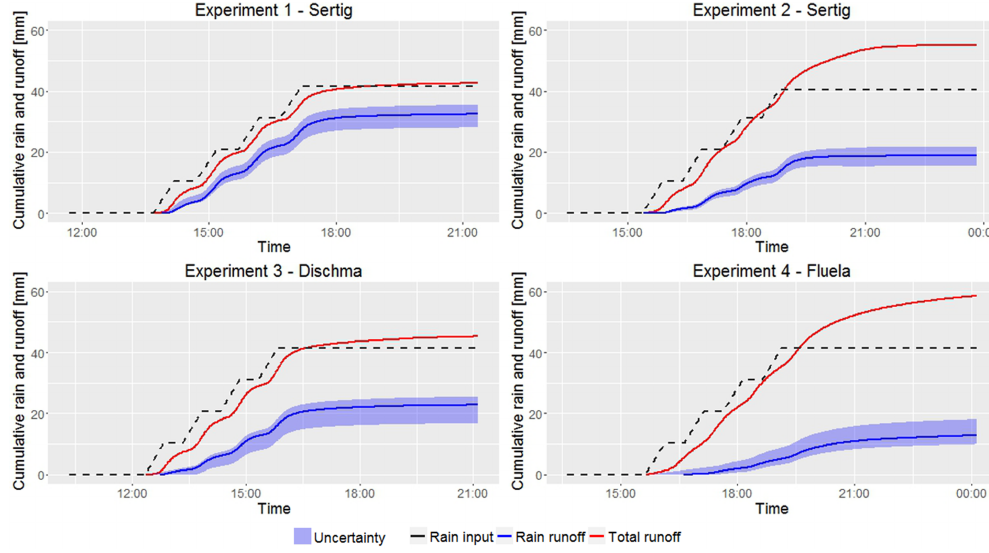
Figure 6. Cumulative runoff from the investigated snow cube. X -axis is in resolution of